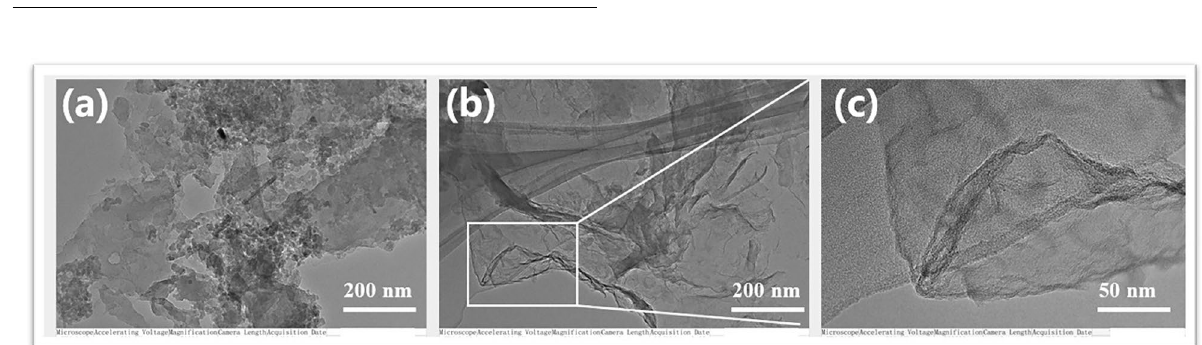
Fig. 5 Morphology changes before and after KOH activation at 700 °C: a OSSC-2; b OSSC-2-700 and c partial enlarged image of